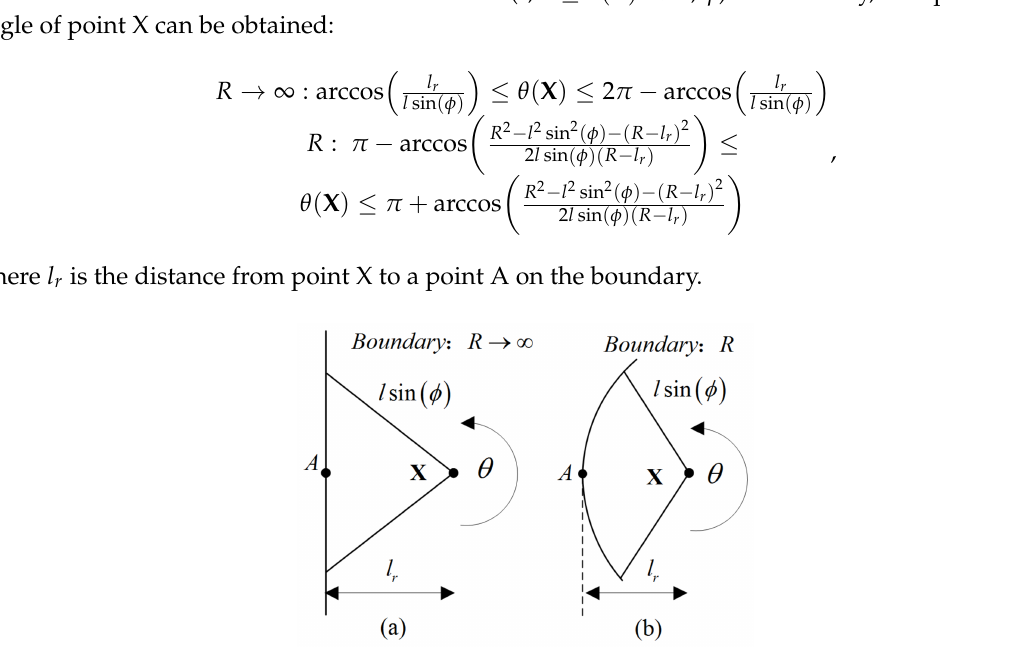
Figure 2. Effect of surface on the distribution of polymer chains on a plane: ( a ) R → ∞ ; ( b ) R